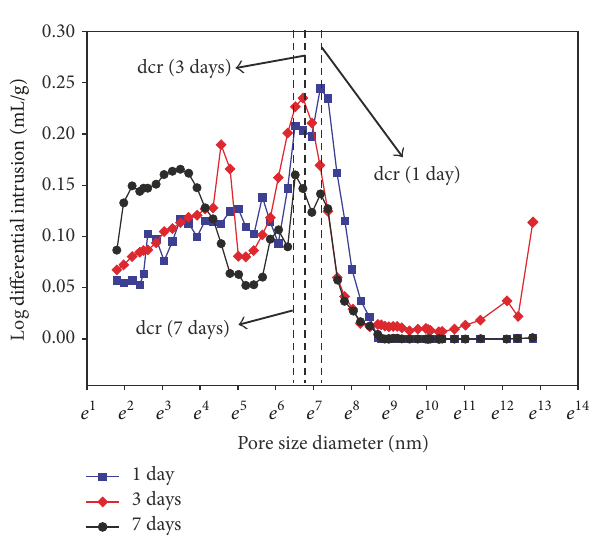
Figure 2: MIP pore size distribution at different curing times.